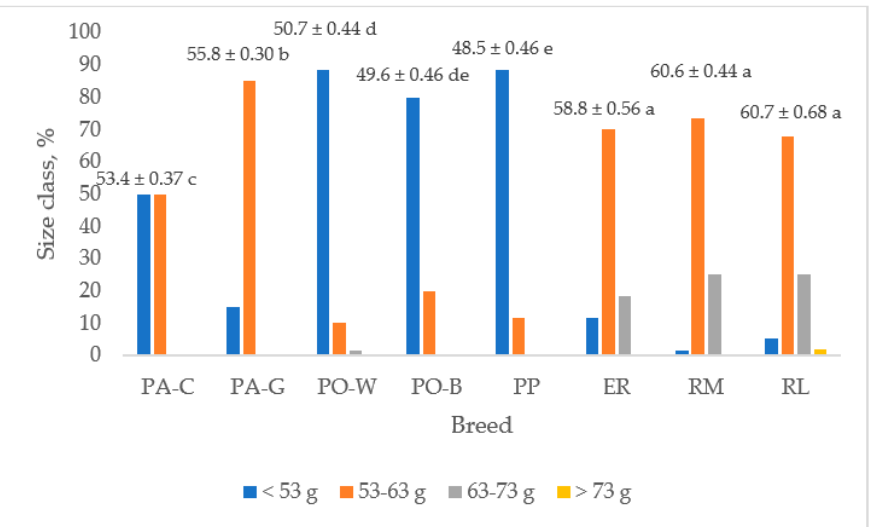
Figure 4. Egg weight (least squares means ± SE) and size class frequency of the breeds (PA ‐ C: Padovana Camosciata; PA-G: Padovana Dorata; PO-W: Polverara Bianca; PO-B: Polverara Nera; PP: Pepoi; ER: Ermellinata di Rovigo; RM: Robusta Maculata; RL: Robusta Lionata). Different letters indicate statistically different means (a,b,c,d,e: p < 0.05). Observation ( n ) = 60 per breed.